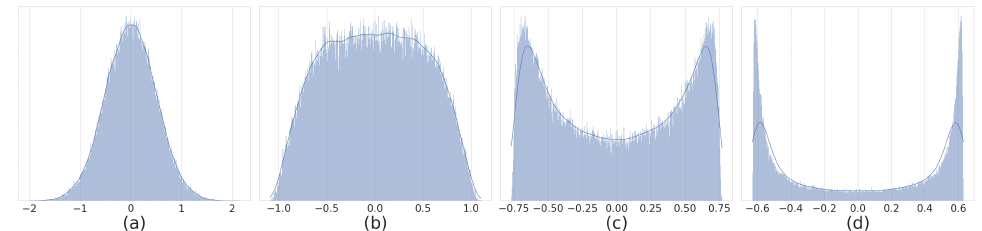
Figure 4. The distribution density function shift with different values of K T of one layer with 100,000 weights. From left to right: K T = 3 ( a ), K T = 1.8 ( b ), K T = 1 ( c ) and K T = − 1.2 ( d ). The last